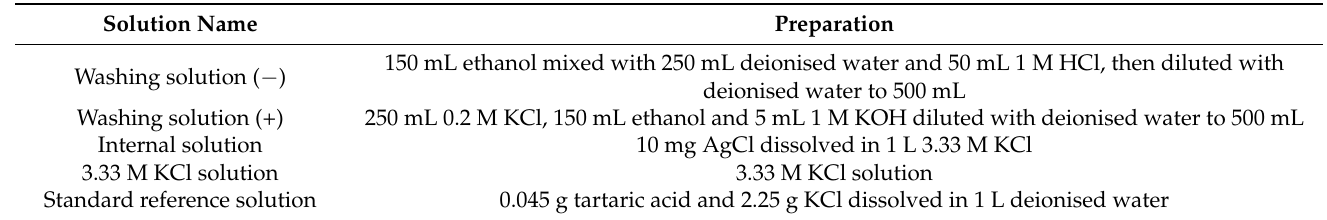
Table A1. Preparation of solutions used in E-tongue testing. “( − )” stands for negatively charged and “(+)” stands for positively charged.